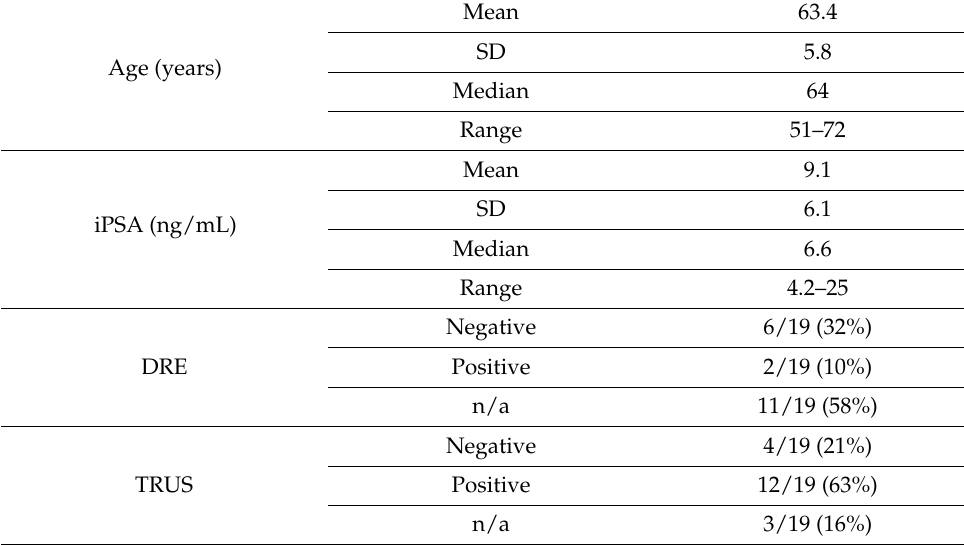
Table 1. Patients’ characteristics ( n =